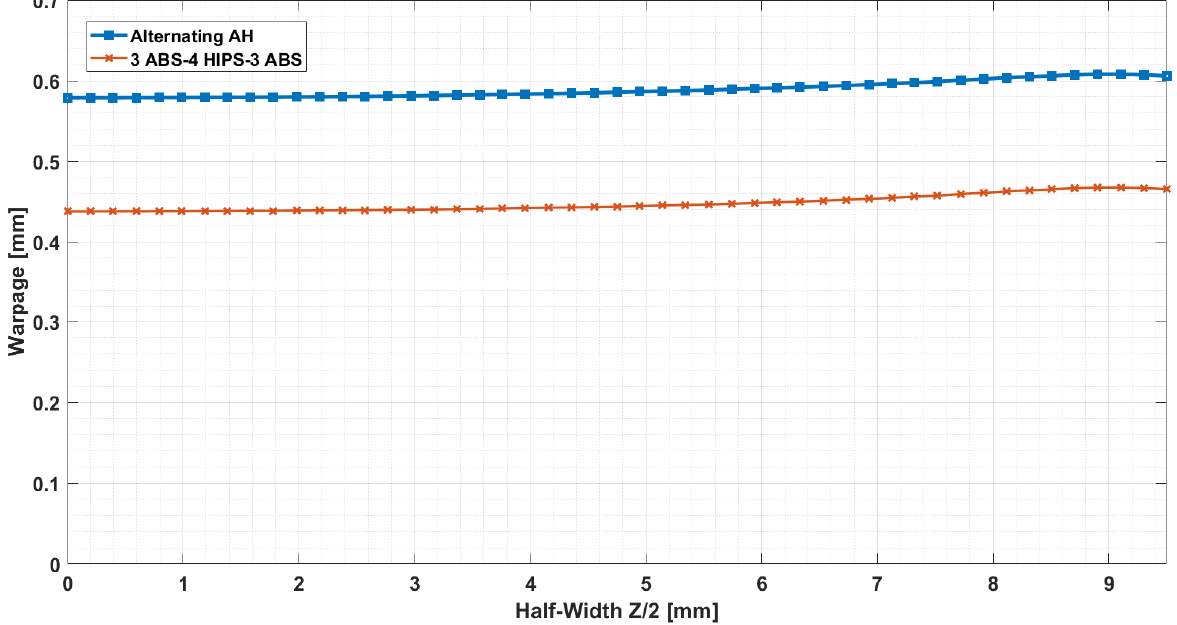
Figure 15. Warpage of multi-material parts along the half-width.